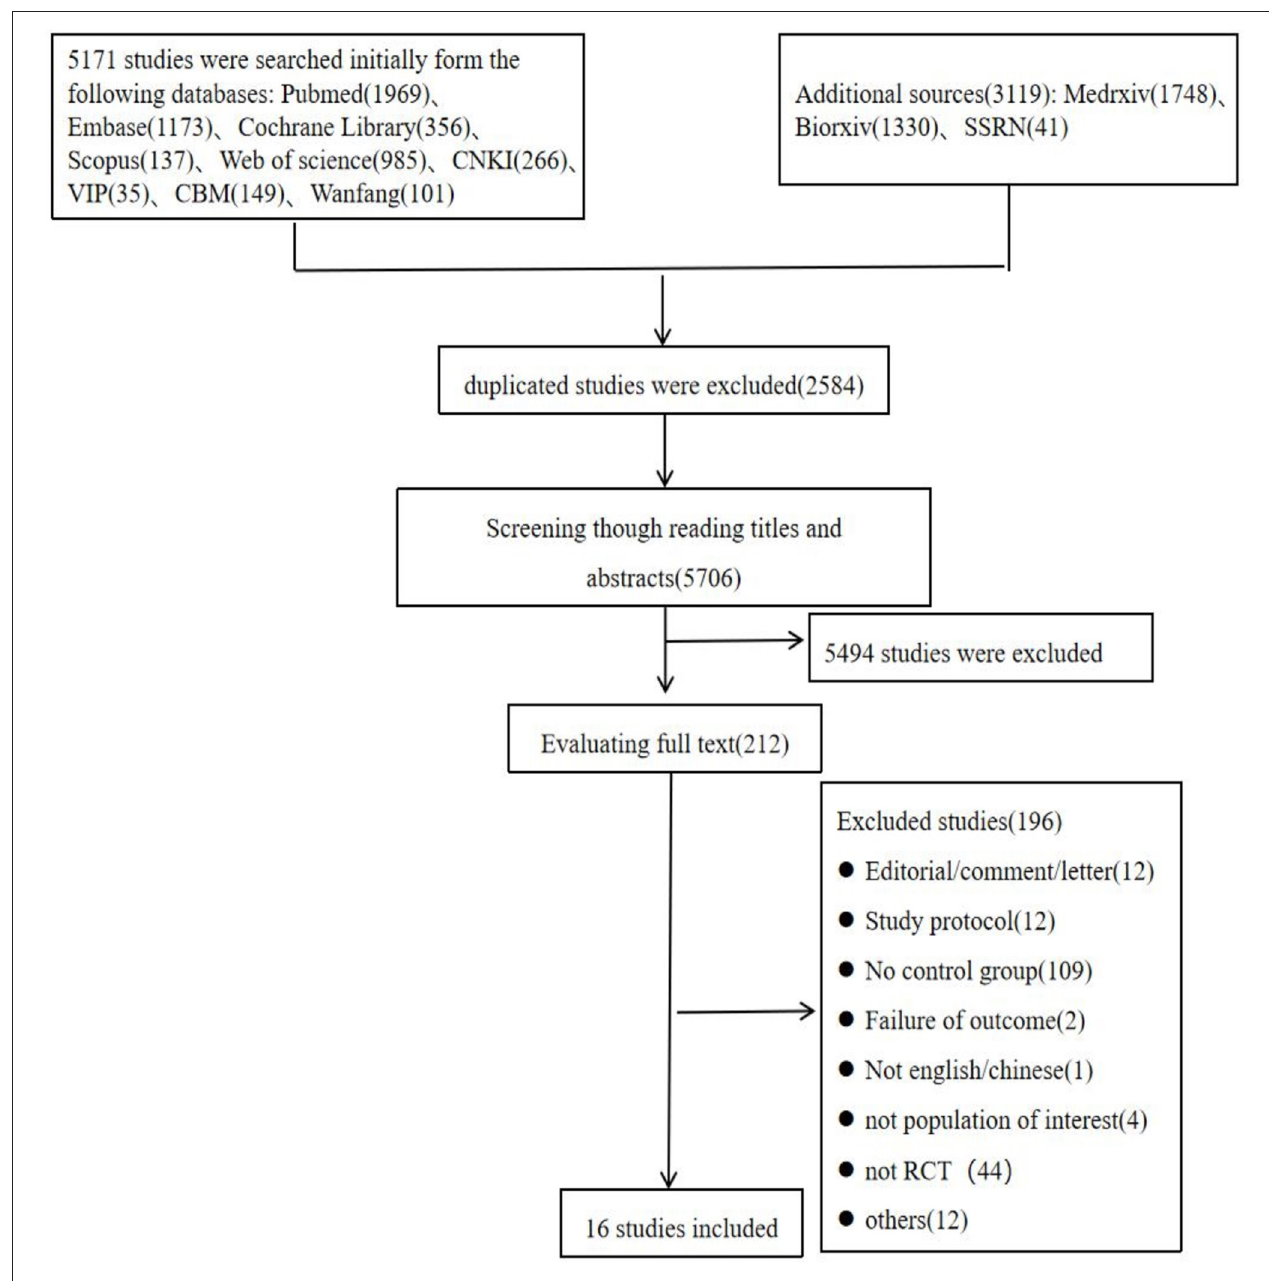
FIGURE 1 | Flow diagram of trial identification and